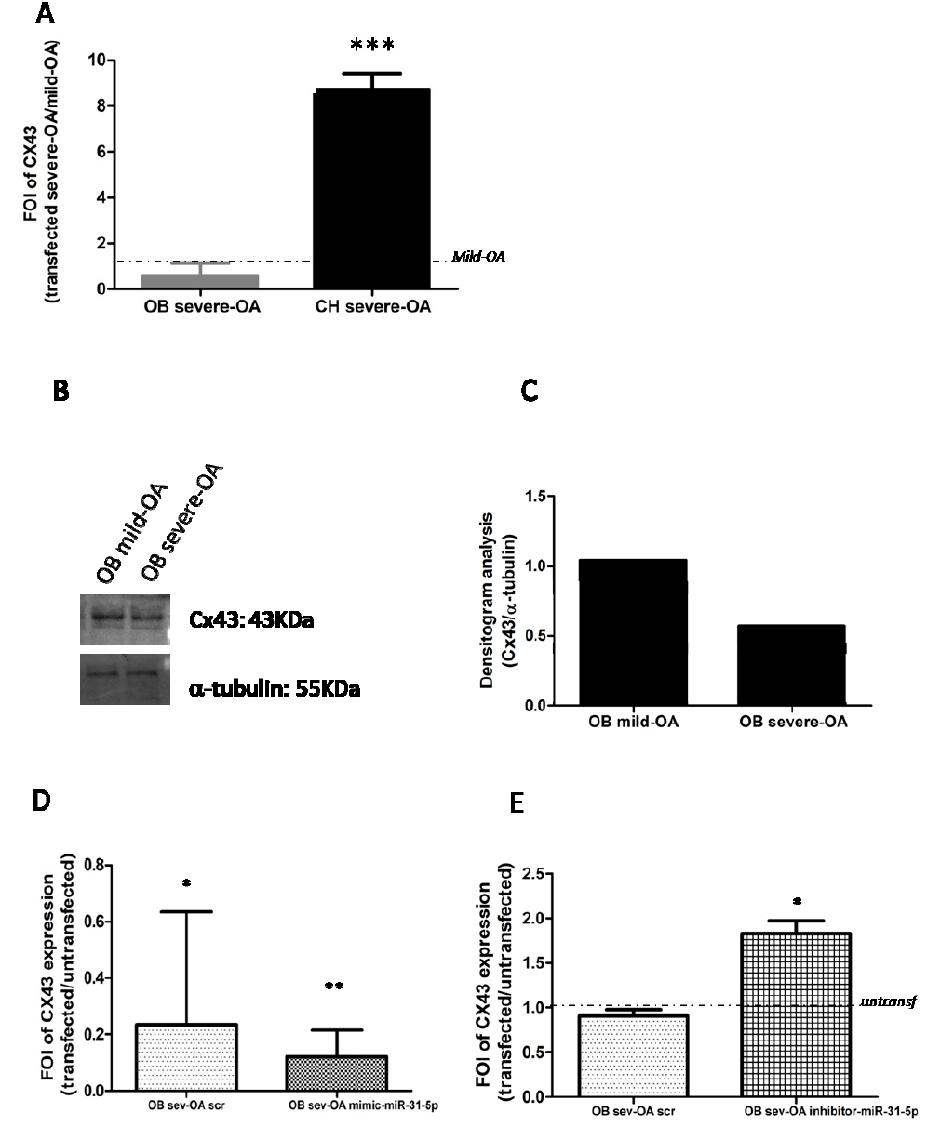
Figure 6. Analysis of CX43 gene and protein expression on osteoblasts (OB) and chondrocytes (CH) derived by patients with severe and mild grade OA. ( A ) qRT-PCR analysis of CX43 gene expression. ( B , C ) Western blot and densitogram analysis of Cx43 and α -tubulin proteins were performed on total cell extract isolated by OB primary cells. ( D ) qRT-PCR analysis of CX43 gene expression in OB isolated by mild OA patients and transfected with miR-31-5p mimic and relative scramble. ( E ) CX43 gene expression analysis by qRT-PCR in OB isolated by severe OA patients and transfected with miR-31-5p inhibitor and relative scramble. qRT-PCR data are expressed as fold of change (FOI) in gene expression (2 − ∆∆ Ct ) occurred in transfected vs untransfected cells. Data reported were analysed by Student t test: *, p < 0.05, **, p < 0.005, ***, p < 0.0005 between experimental group and represented as mean ± SD ( n = 4).